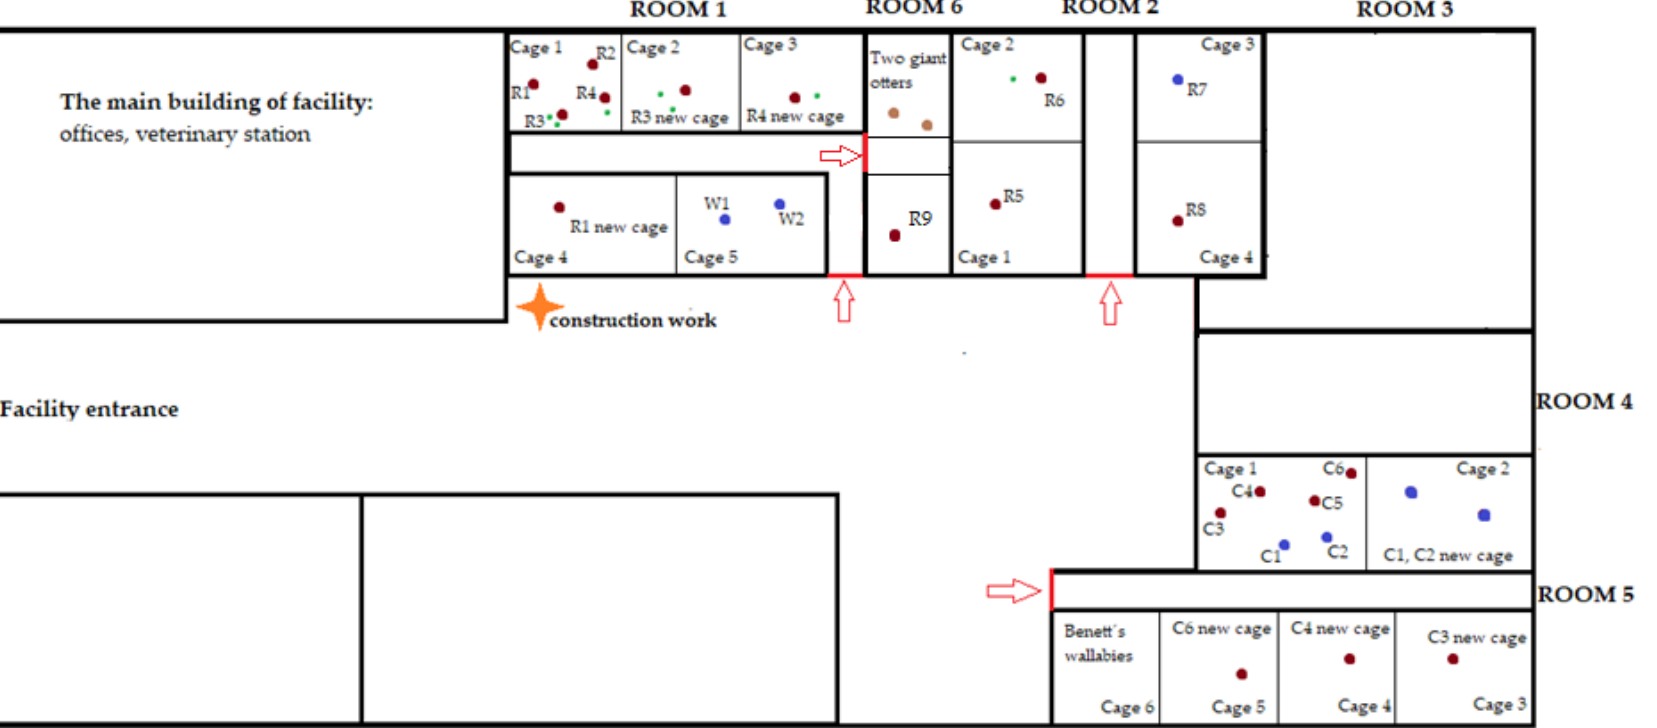
Figure 1. Scheme of floor plan of the facility and relocation of individuals. Red points indicate females; blue points indicate males; green points indicate offspring; red arrows indicate the entrance to the rooms. R1 – R9 indicate ring-tailed lemurs 1 – 9; W1 – W2 indicate white-headed lemurs 1 – 2; C1 – C6 indicate collared brown lemurs 1 – 6.